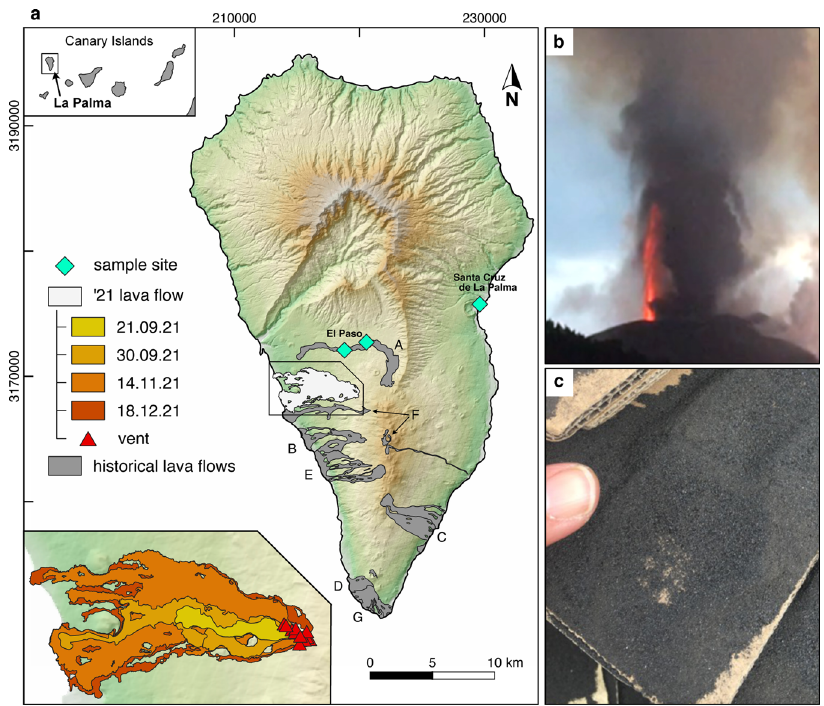
Fig. 1 Overview of the geological setting, eruptive behavior, and ash sampling at Cumbre Vieja. a Map of La Palma, Canary Islands showing the locations of the September 2021 eruptive vents, (El Paso), along with the resultant lava fl ows. Historic lava and tephra eruptions of La Palma are also shown as gray colored zones and correspond to the Mtña. Quemada (A; 1430/1440), Jedey (B; 1585 CE), Martin (C; 1646 CE), San Antonio (D; 1677), El Charco (E; 1712), San Juan (F; 1949), and Teneguia (G; 1971) eruptions. b This study utilized fresh basanite ash produced during the 14 – 20 November explosive activity, which comprised fi re fountains (500 – 2000 m) that brought coarse ash to the points of sampling, shown with diamond symbols. Ash was collected within hours of being deposited on fl at surfaces ( c ). The map (frame a ) uses data of the Copernicus GLO-30 Digital Elevation Model (European Space Agency, Sinergise 2021). Lava fl ow data of the 2021 eruption of Cumbre Vieja was provided by the Copernicus Emergency Management Service (European Union 2021), EMSR546. The data of historical lava fl ows is based on the MAGNA 50 geological map provided by the Instituto Geologico y Minero de Espana via Web Map Service and is modi fi ed after refs. 18 and 25